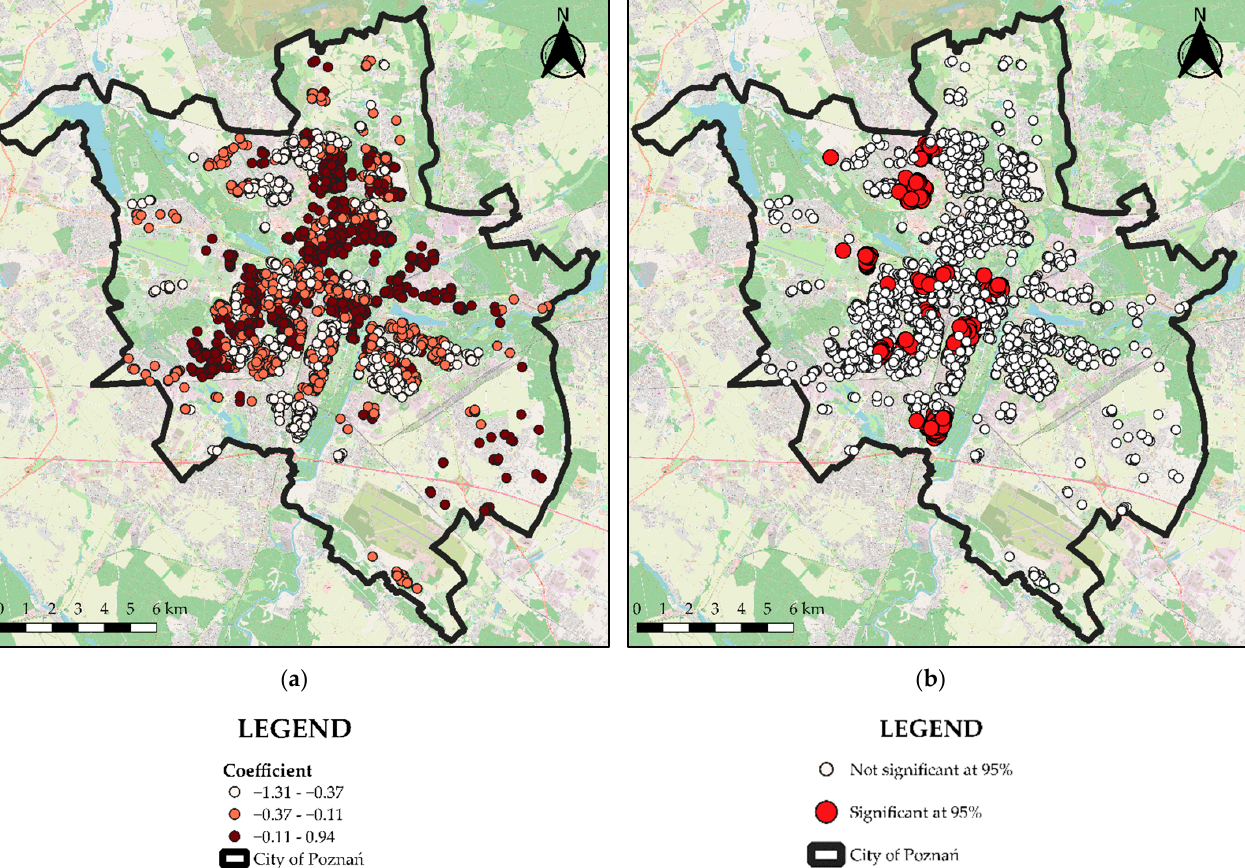
Figure 5. ( a ) Local estimated coefficients—SA. ( b ) Statistical significance of estimated coefficients—SA.